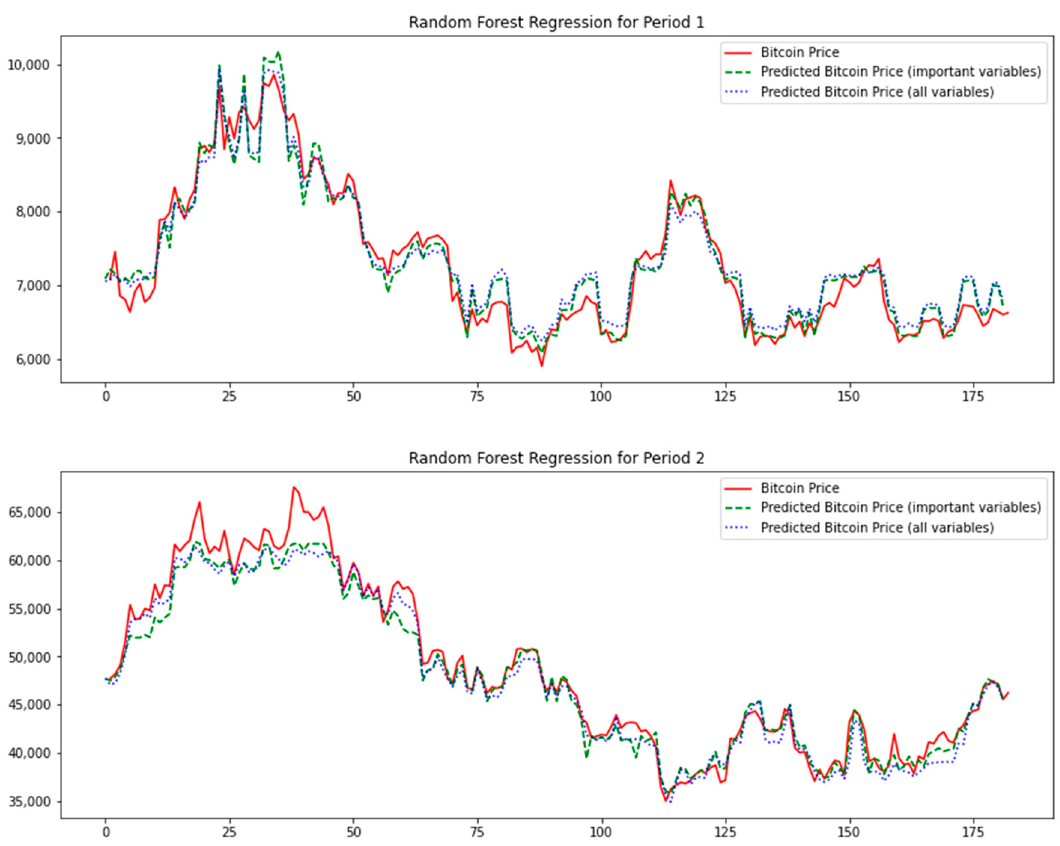
Figure 11. RFR results by all variables and only important variables.